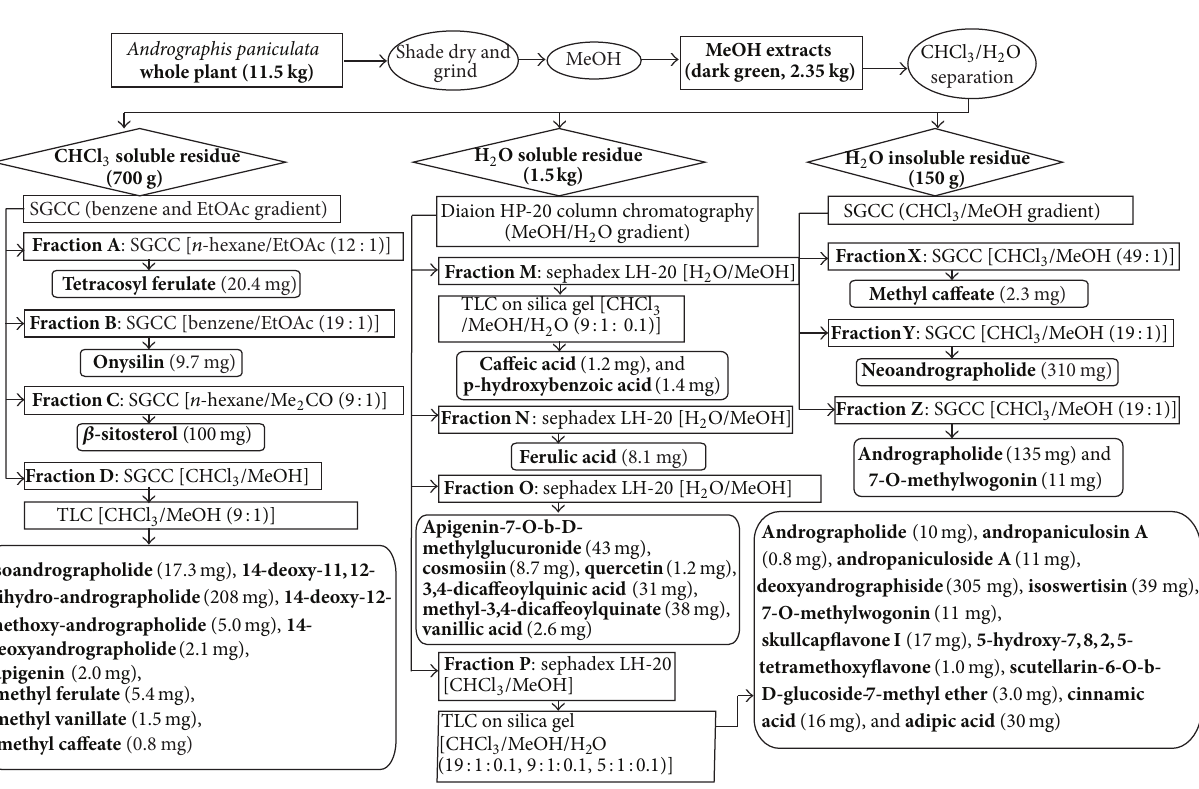
Figure 2: Extraction of pure compounds of A. paniculata from MeOH extracts. Yield of pure compounds is in bracket in mg. Their structures have been elucidated mainly by 1D and 2D NMR and MS spectroscopic methods. SGCC: silica gel column chromatography; TLC: thin layer chromatography, MeOH: methanol; EtOAc: ethyl acetate, CHCl 3 : chloroform (adopted from